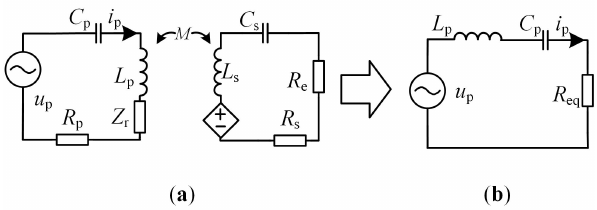
Figure 4. Equivalent circuit for transient analysis. ( a ) Full-order reflected impedance circuit model. ( b ) Simplified equivalent circuit